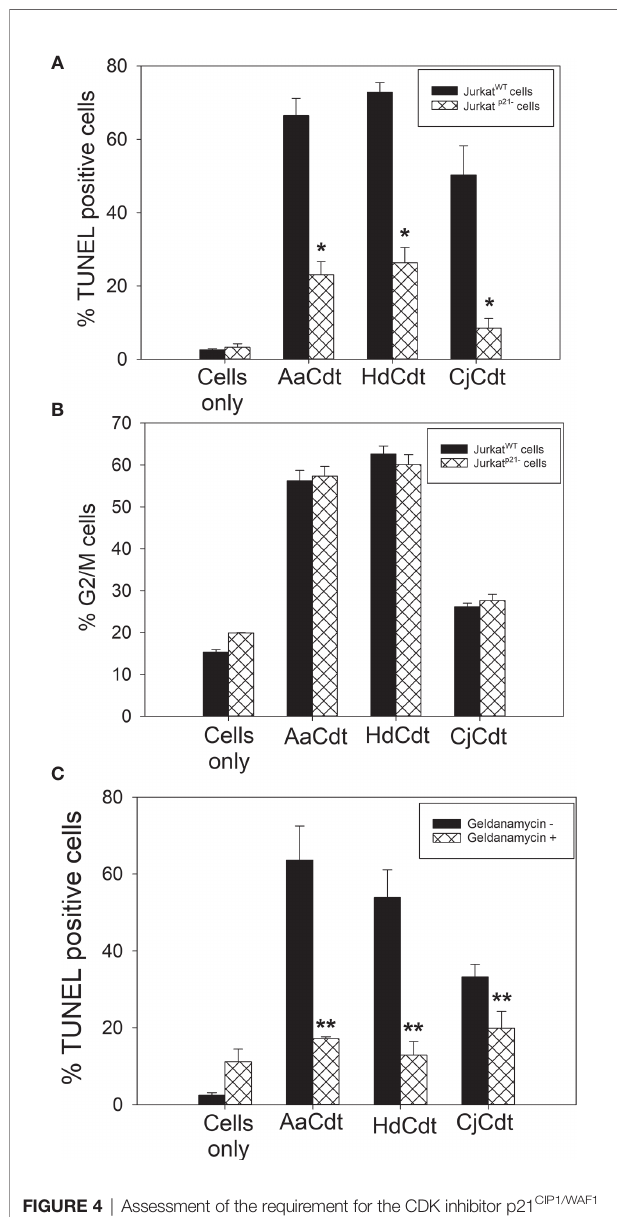
FIGURE 4 | Assessment of the requirement for the CDK inhibitor p21 CIP1/WAF1 in Cdt-induced toxicity. (A) Jurkat WT cells and Jurkat p21CIP1/WAF1- were treated with AaCdt, HdCdt and CjCdt (same concentrations as above) for 48hr and then analyzed for apoptotic cells by determining the percentage of TUNEL positive cells as detailed in Materials and Methods. The percentage of apoptotic cells is plotted for both Jurkat WT (solid bars) and Jurkat p21CIP1/WAF1- (cross hatched bars) cells and represent the mean ± SEM of three experiments. *indicates statistical signi fi cance (p < 0.01) when compared to Jurkat WT . (B) Jurkat WT cells and Jurkat p21CIP1/WAF1- were treated with AaCdt, HdCdt and CjCdt for 16hr and assessed for the percentage of cells in the G2/M phase of the cell cycle as described in Materials and Methods. The percentage of G2/M cells is plotted for both Jurkat WT (solid bars) and Jurkat p21CIP1/WAF1- (cross hatched bars) cells and represent the mean ± SEM of three experiments. (C) Jurkat cells were pre-treated with medium (solid bars) or Geldanamycin A [GA; (cross-hatched bars)] for one hr before the addition of Cdt. Cells were analyzed for apoptosis using the TUNEL assay 48 hr later; results represent the mean ± SEM of three experiments. **indicates statistical signi fi cance (p <